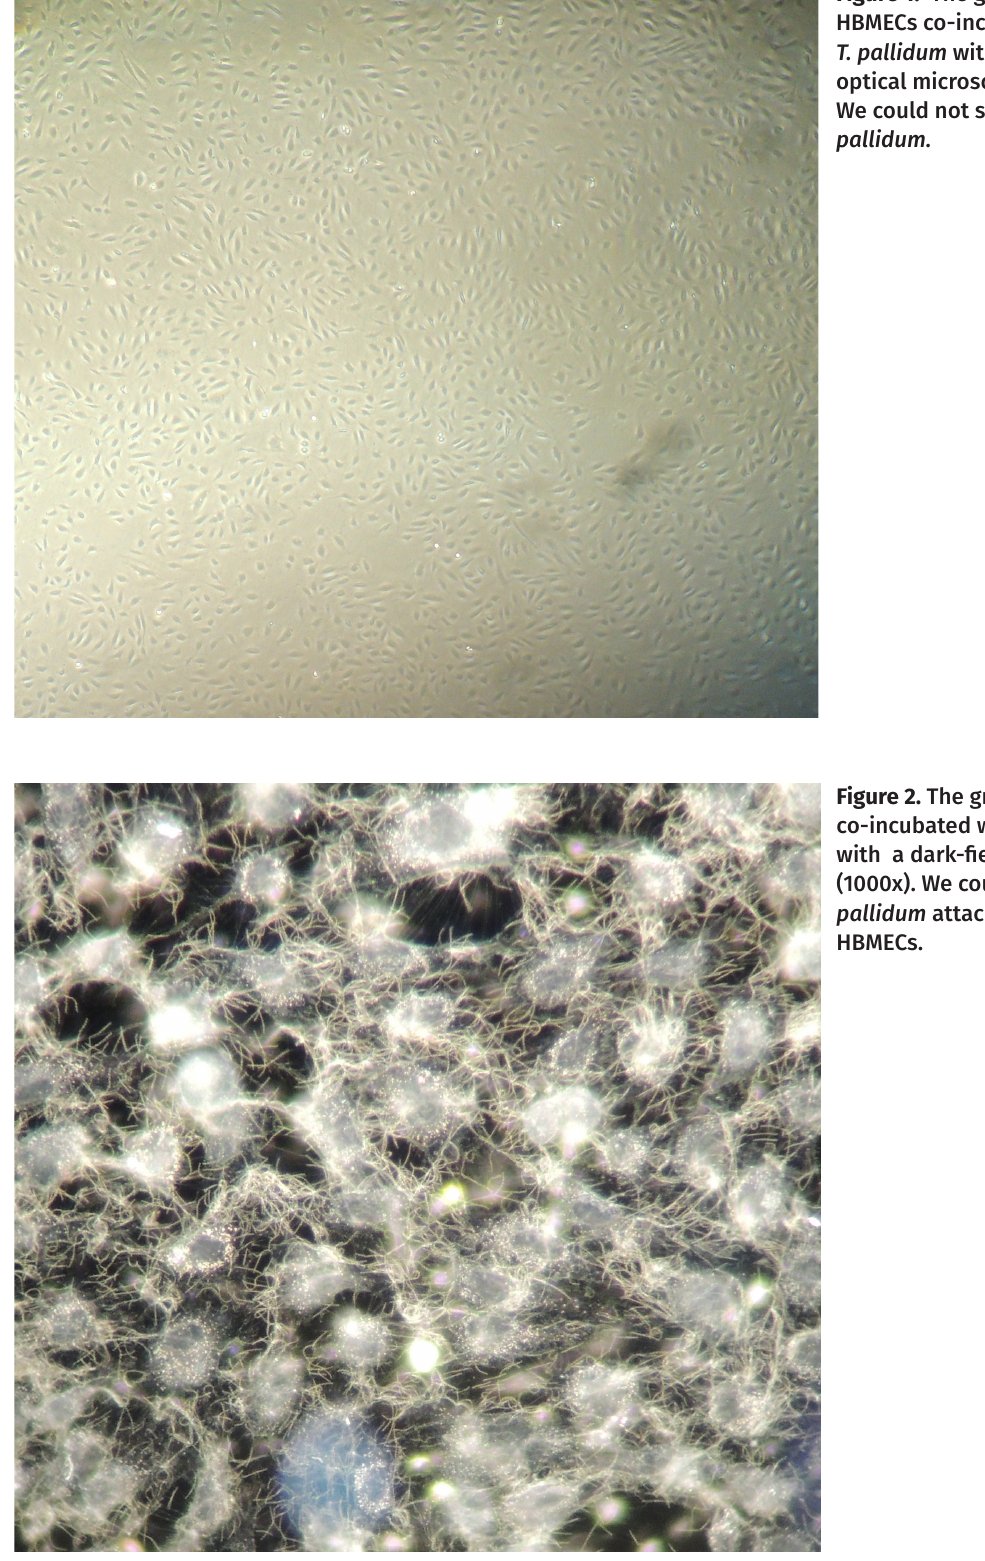
Figure 1. The graph of HBMECs co-incubated with T. pallidum with an ordinary optical microscope (400x). We could not see the T. pallidum.